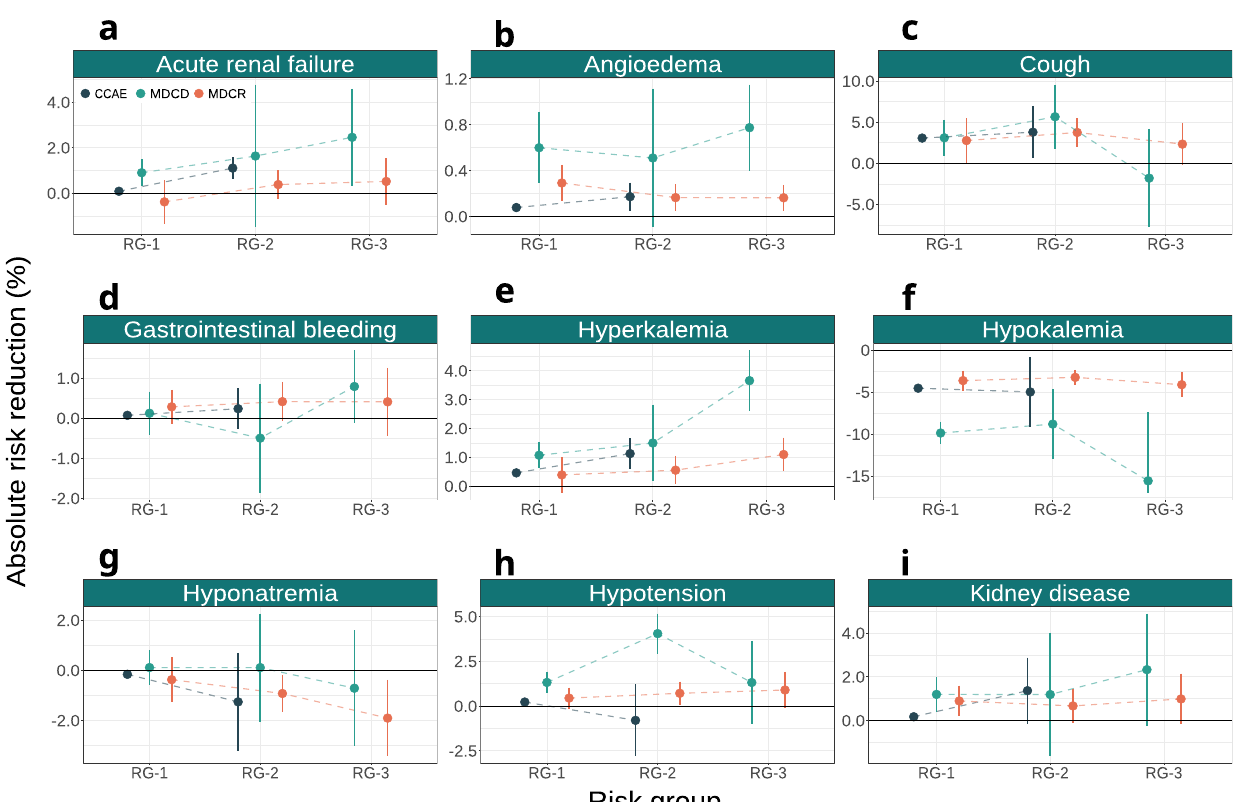
Fig. 8 Absolute treatment effects for safety outcomes. Treatment effect heterogeneity for the safety outcomes on the absolute scale of thiazide or thiazide-like diuretics compared to ACE inhibitors within strata of predicted acute MI risk. Panels present treatment effects on the absolute scale for a acute renal failure, b angioedema, c cough, d gastrointestinal bleeding, e hyperkalemia, f hypokalemia, g hyponatremia, h hypotension, and i kidney disease within groups of predicted acute MI risk across all three databases. RG-1 represents the group of patients with acute MI risk below 1%; RG-2 represents the group of patients with acute MI risk between 1% and 1.5%; RG-3 represents the group of patients with acute MI risk larger than 1.5%. Absolute treatment effects estimated in CCAE, MDCD, and MDCR are represented by blue, green, and orange circles, respectively. The bars represent 95% con fi dence intervals. Values above 0 favor thiazide or thiazide-like diuretics, while values below 0 favor ACE